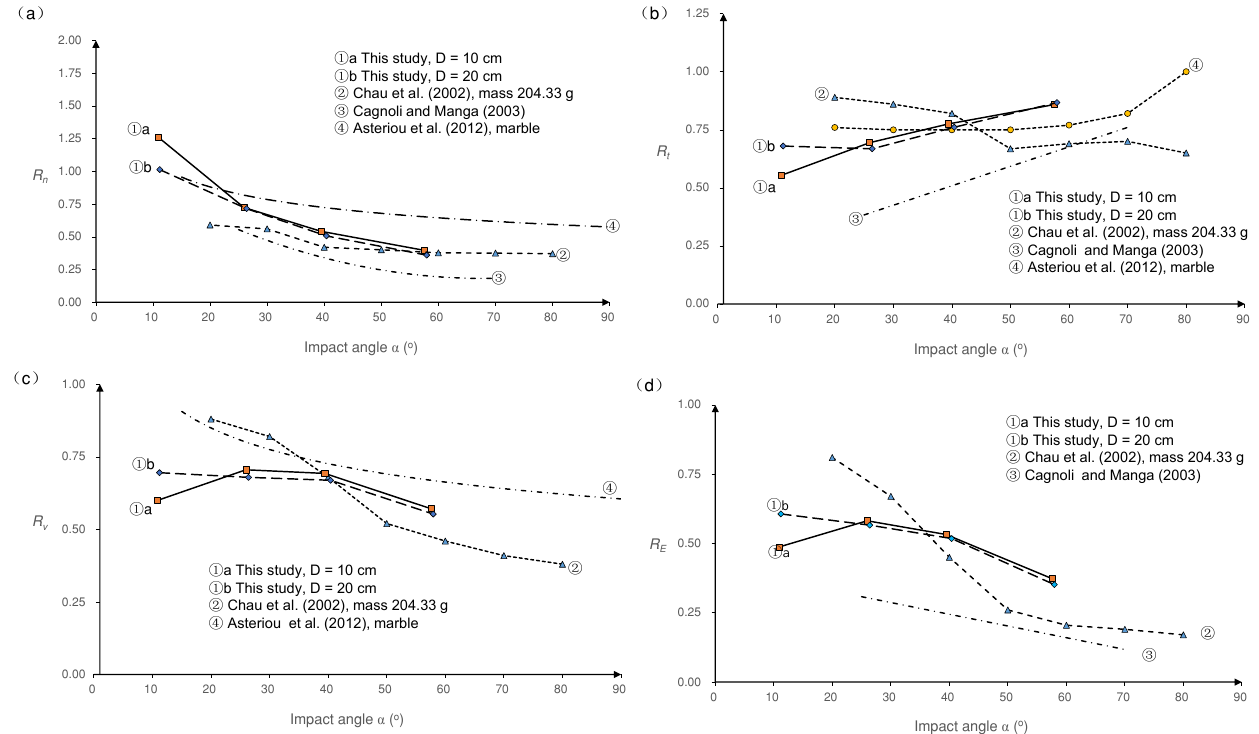
Figure 6. Results comparison between this study and existing small-scale experiments in terms of the effect of the impact angle on the four coefficients of restitution: (a) the normal coefficient R n , (b) the tangential coefficient R t , (c) the kinematic coefficient R v and (d) the kinetic energy coefficient R E . The mean value lines (lines with data markers) or the fitting lines (lines without markers) are adopted in accordance with the original literature (Chau et al., 2002; Cagnoli and Manga, 2003; Asteriou et al.,